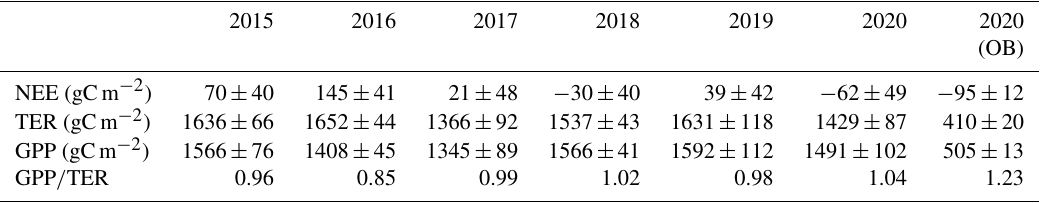
Figure 2. Seasonal variation in mean daily air temperature ( T a ) at meteorological station Toropets, 10d precipitation sums at meteorological station Lesnoy Zapovednik (MS) (a) , daily global radiation sums at the paludified forest (PF) (b) , mean daily soil temperature at 5cm depth ( T s ) (c) , and inverse value of water table depth (WTD − 1 ) at the PF and ombrotrophic bog (OB) sites, correspondingly, in the period 2015–2020. Table 3. Annual sums of the net ecosystem exchange (NEE), total ecosystem respiration (TER), and gross primary production (GPP), with uncertainty estimates associated with random error in the measured fluxes, u ∗ threshold estimation, gap-filling and flux partitioning procedures ( ± SD), and GPP / TER ratio at the paludified forest (PF) in the period 2015–2020 and at the ombrotrophic bog (OB) in